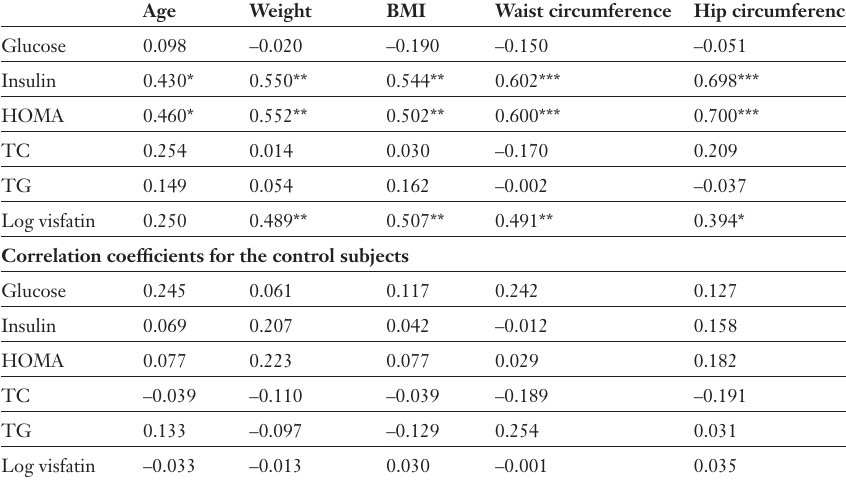
Correlation coefficients for obese children